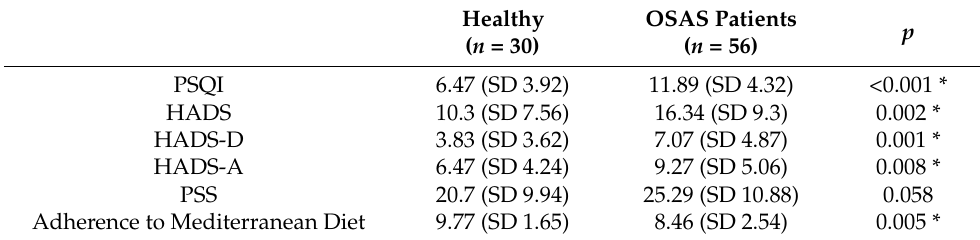
Table 4. Questionnaires results between healthy individuals and patients with OSAS.